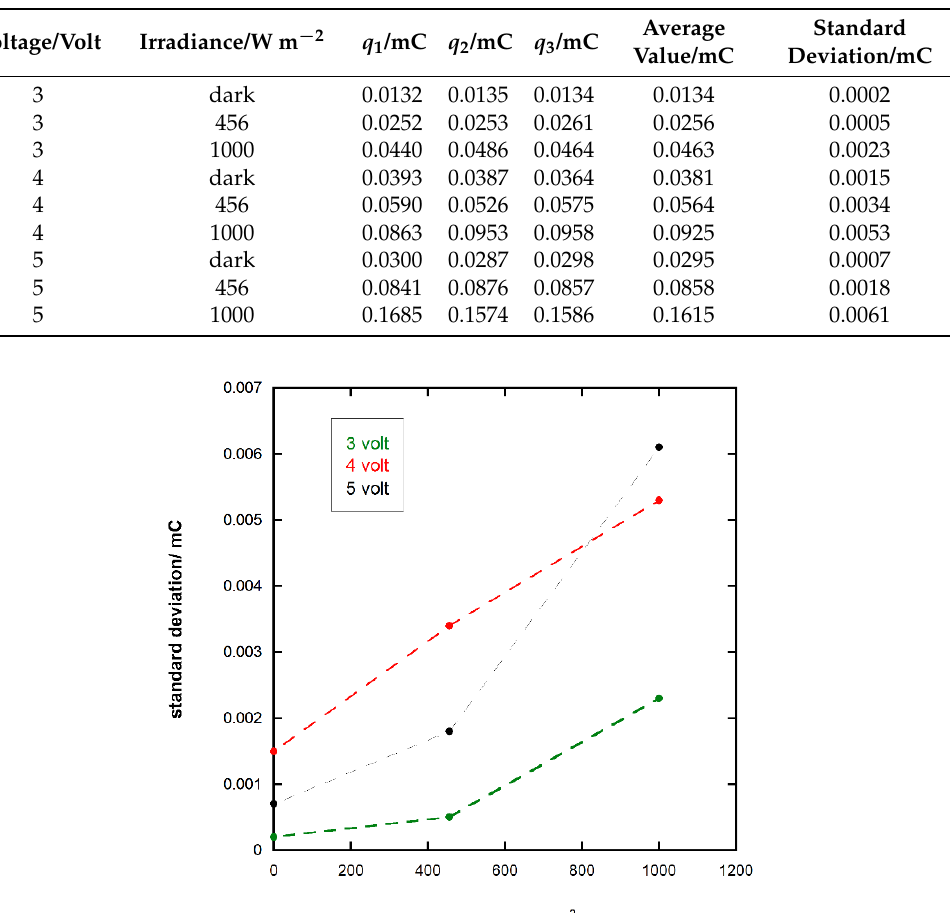
Table 2. Generated charge, q , as a result of voltage pulse on three consecutive pulses at different irradiance conditions, their average values, and standard deviations.